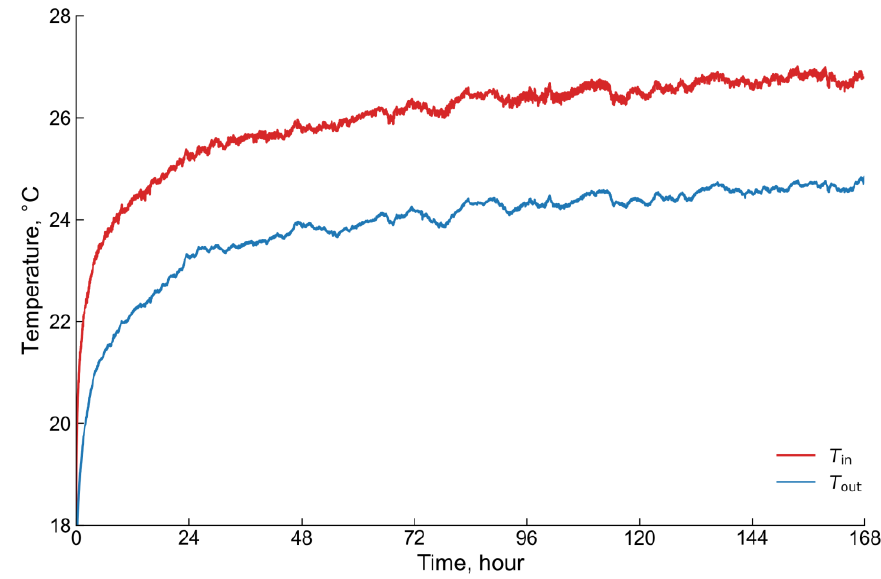
Figure 4. Temperature variation at the inlet and outlet parts of the BHE.